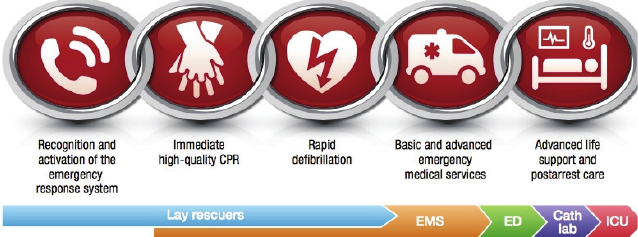
Figure 1 - ACS handling chains or survival chains (AHA,